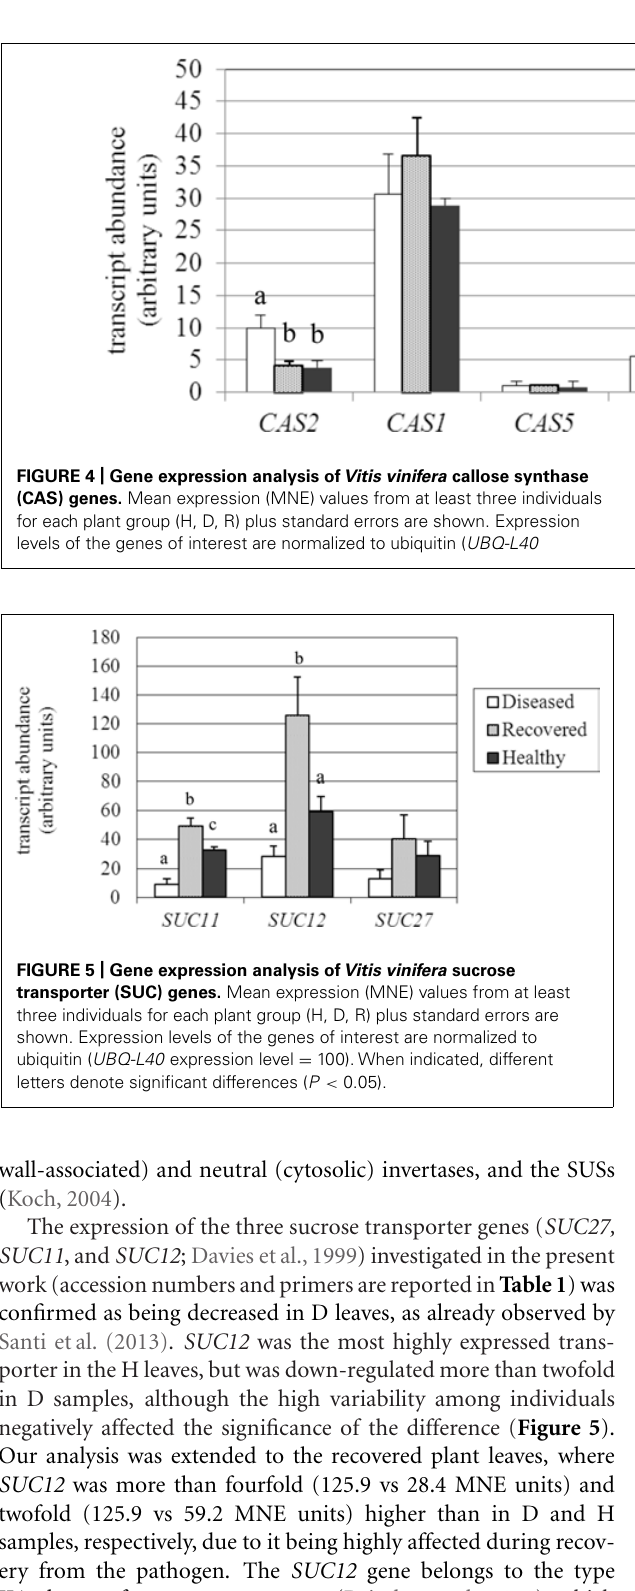
wall-associated) and neutral (cytosolic) invertases, and the SUSs (Koch,